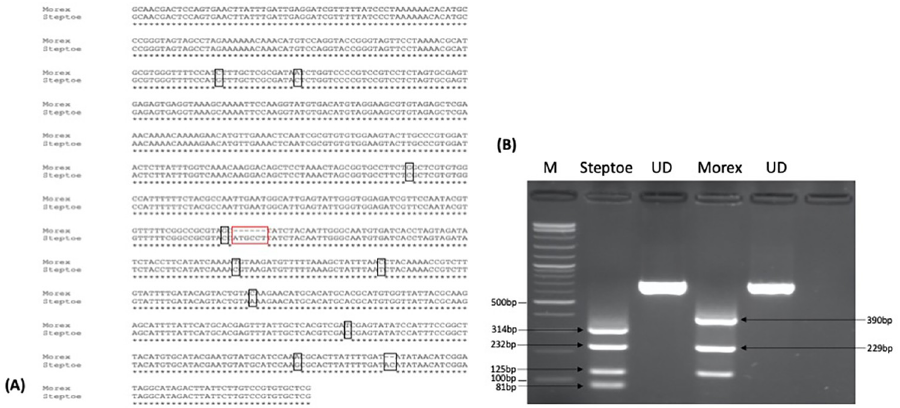
Fig 3. (A) Alignment of 1000bp downstream 3’ UTR region of HvTLP8 in Steptoe (six-row feed) and Morex (six-row malt) varieties. The red box indicates the difference that resulted in the additional MwoI restriction site in Steptoe. Black boxes indicate SNPs. (B) Digestion of 1000 bp downstream 3’ UTR region of HvTLP8 fragment with MwoI in Steptoe and Morex. UD: Undigested PCR product. M: 1kb plus